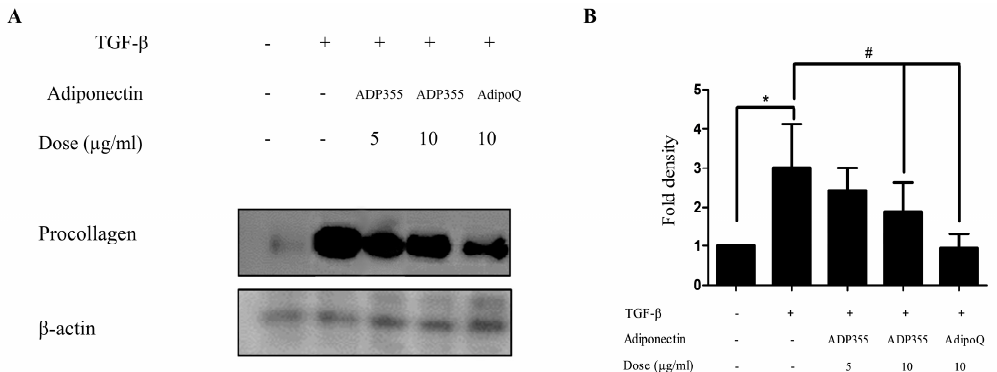
Figure 2. Effect of ADP355 on transforming growth factor β 1 (TGF- β 1)-induced procollagen expression. Treatment of ADP355 (5 and 10 µg/mL) and adiponectin recombinant, AdipoQ (10 µg/mL), simultaneously with TGF- β 1 10 µg/mL of ADP355 and AdipoQ, attenuated TGF- β 1-induced procollagen expression. ( A ) Western blot analysis results. ( B ) Quantification of western blot results (* p ≤ 0.05, control vs. TGF- β 1, # p ≤ 0.05, TGF- β 1 vs. TGF- β 1 + ADP355, and TGF- β 1 vs. TGF- β 1 + AdipoQ). The data are expressed as mean ± SD. Representative data are shown from three independent experiments.